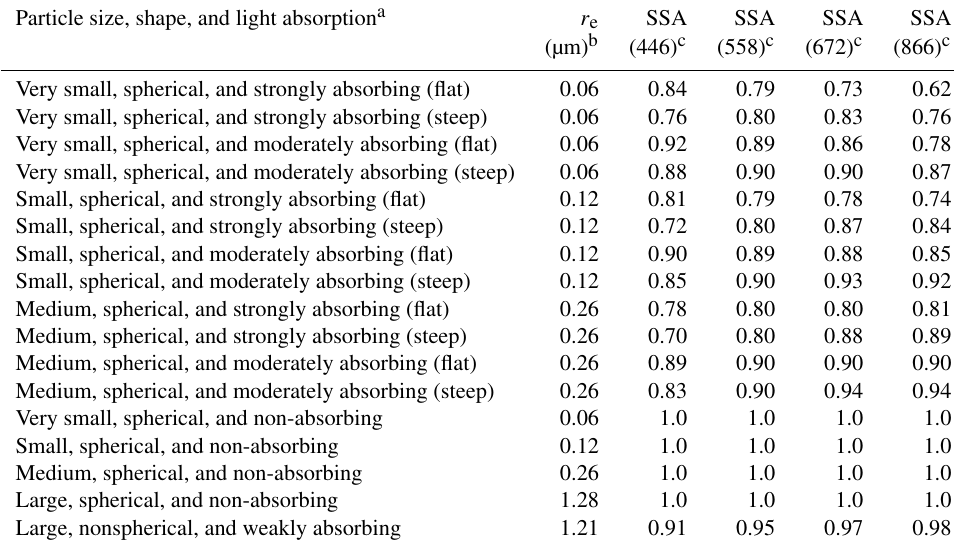
Table 1. MISR components from Research Aerosol (RA) retrieval results, using the algorithm version summarized in Sect. 2.1, with a 774-mixture climatology. SSA denotes single-scattering albedo. Particle size, shape, and light absorption